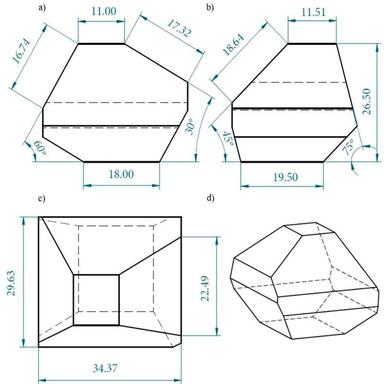
Nominal dimensions (in mm) of four-faced part. Manufactured by SLS. a) Front. b) Left. c) Top. d) 3D view.